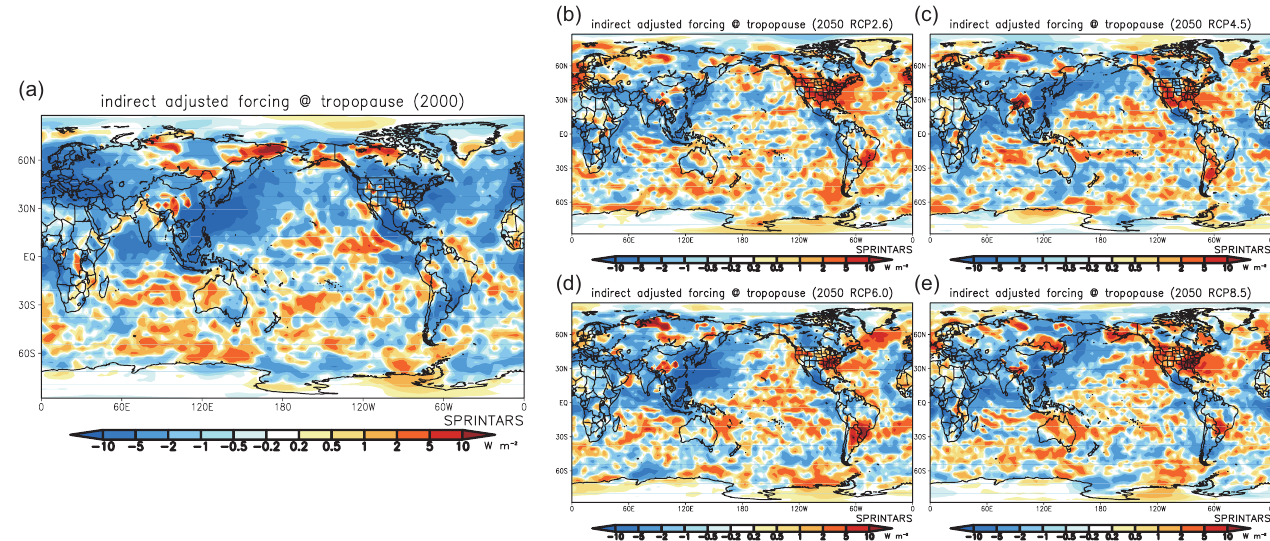
Fig. 15. Global distributions of adjusted forcing due to the aerosol indirect effect at the tropopause in (a) 2000 (averaged over the period 1998–2002) and (b) – (e) 2050 (averaged over the period 2048–2052) for the four RCPs relative to the preindustrial experiment simulated by SPRINTARS.